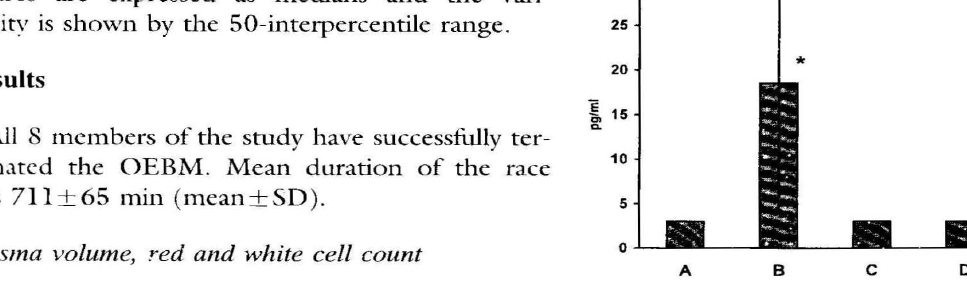
Figure 2. Interleukin-6 in serum before the Oetztal bi cycle marathon (=A), immediately after finishing the race (=B), as well as after one (=C), two (=D), three (=E ) and five C=F) days post race. Interleukin-6 at A and C-F were below the detection limit of the assay. Data shown at B are median values with the 25 th and 75 th pel'centi1t:, respectively. *indicates p<0.05 .